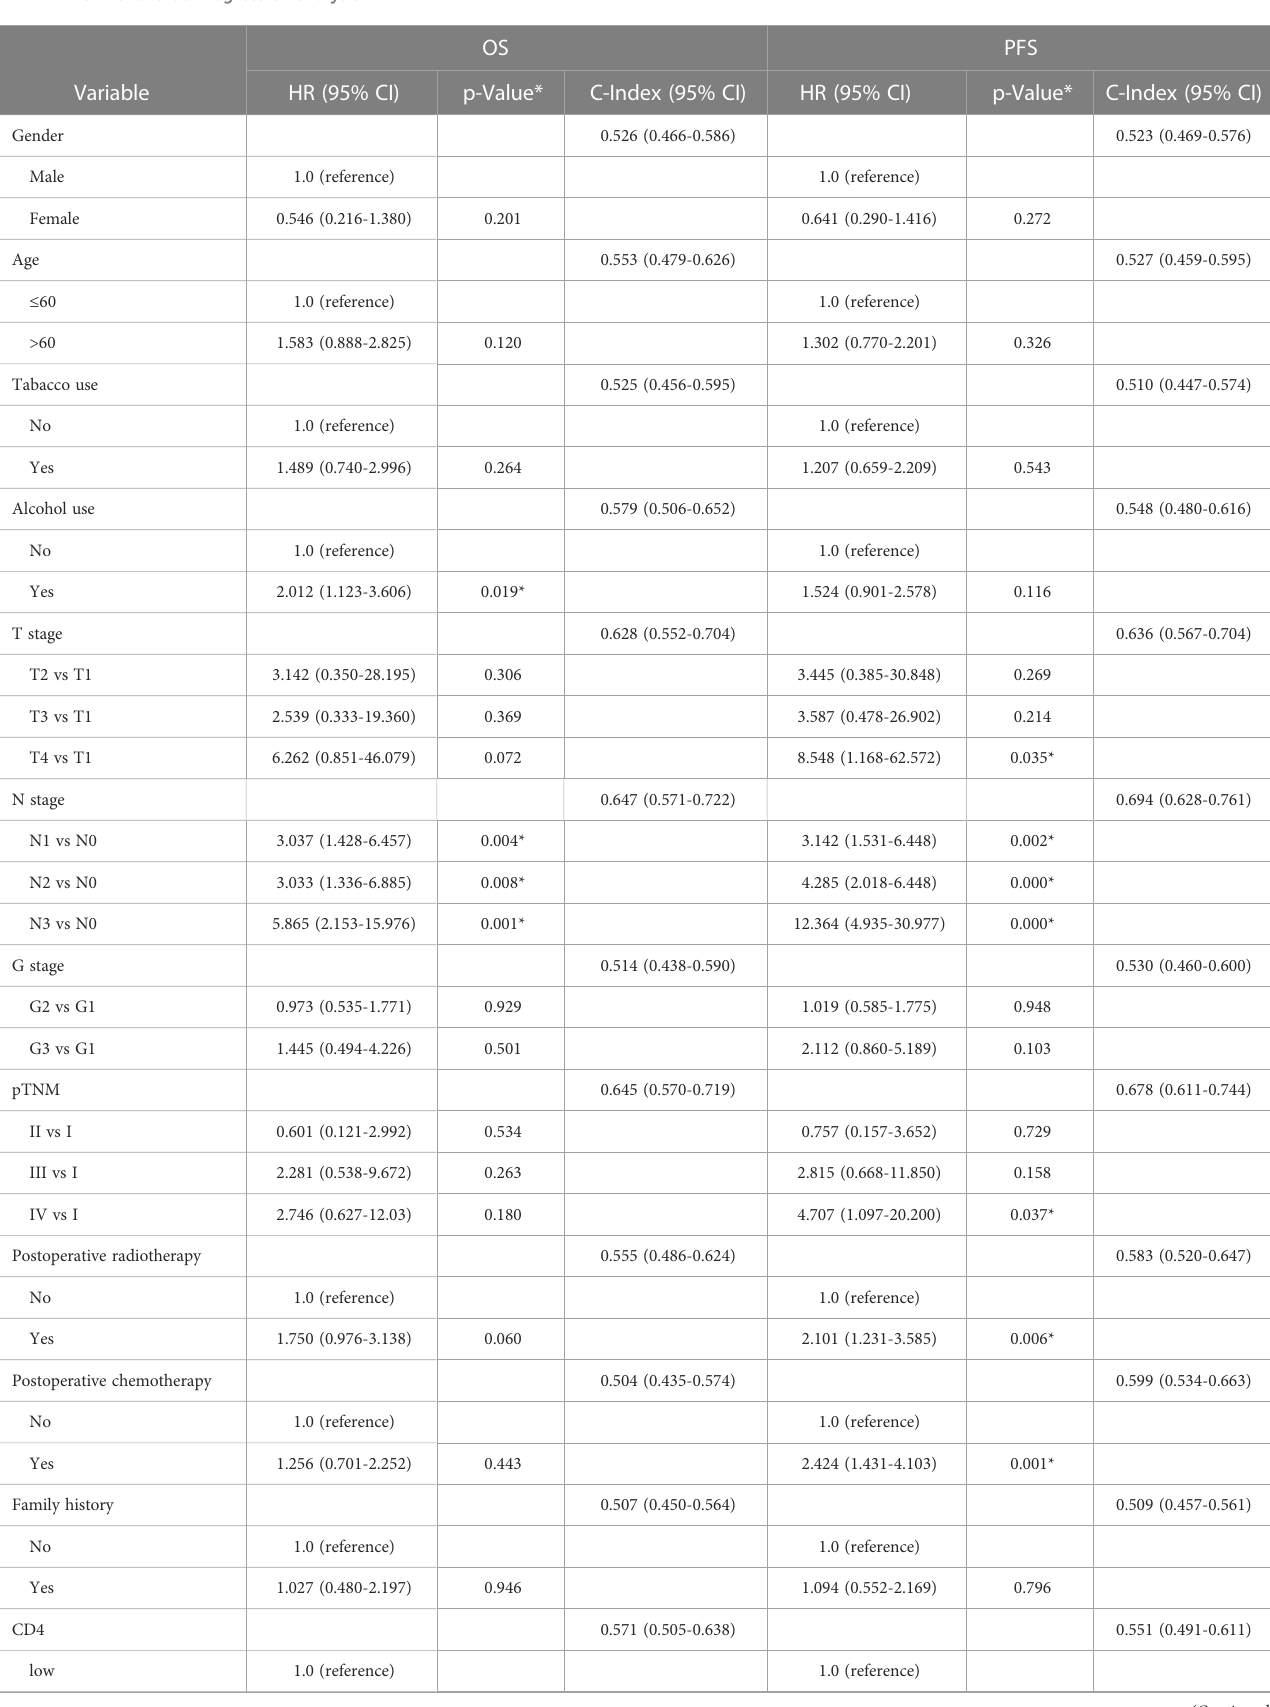
TABLE 2 Univariate Cox regression